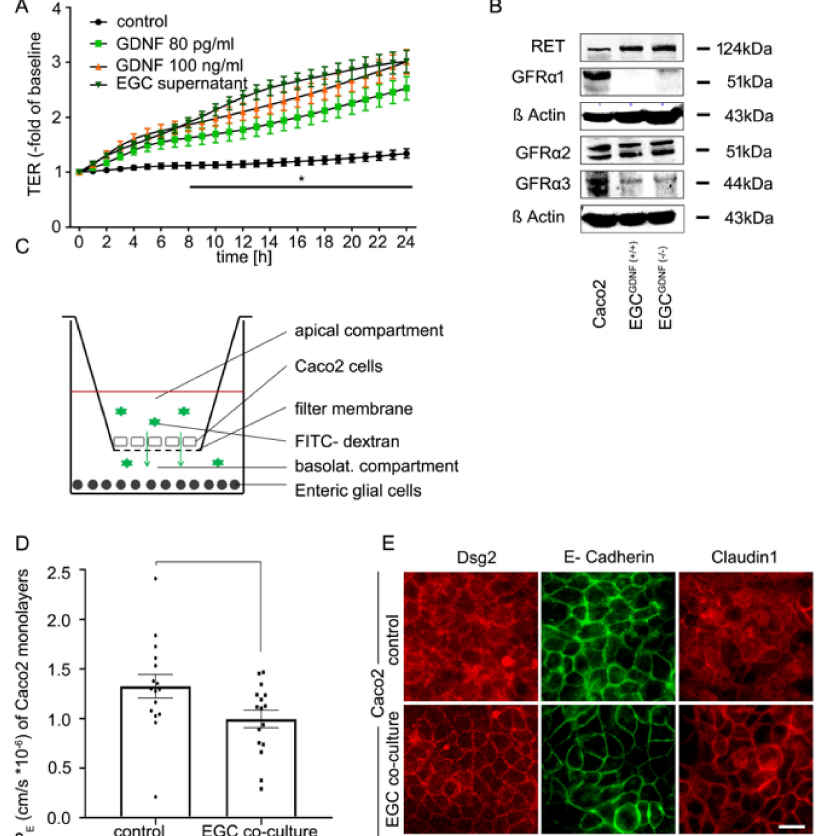
Figure 2. Co-culture of enteric glial cells (EGC) with Caco2 cells stabilizes epithelial barrier function. ( A ). Measurements of transepithelial electric resistance (TER) showed a significant increase beginning at 8 h after incubation with the supernatant of EGC and raised to 3.01 ± 0.1-fold of baseline (equates to 2.24-fold of controls) while incubation with glial cell line-derived neurotrophic factor (GDNF) at 100 ng/mL increased TER significantly to 2.99 ± 0.07 of baseline (2.23-fold of controls) after 24 h. Similar results were obtained when GDNF was applied at 80 pg/mL when TER increased to 2.52 ± 0.09 -fold of baseline (1.88-fold of controls); ( n = 6, * = significant different vs. control after 8 h for all other conditions; p < 0.05, two-way ANOVA). Control = Caco2 monolayer without treatment. ( B ). Western Blots of Caco2 cells and EGC cells (wilde type (WT) and GDNF-knockdown) confirmed that all these cell lines express GDNF receptors and RET ( n = 3). Quantification of the blots is shown in Supplementary Figure S1 ( C ). Schematic picture of the co-culture model of Caco2 cells and enteric glia cells. ( D ). Permeability coefficients (P E ) of 4-kDa FITC dextran flux across Caco2 monolayers were significantly reduced 24 h after co-culture with EGC ( p < 0.05, n = 16, student’s t-test). Control = Caco2 monolayer without treatment. ( E ). Immunostaining of the transwell filters showed an augmented and more linear staining pattern of desmosomal protein Desmoglein2 (Dsg2), adherens junction protein E-Cadherin and tight junction protein Claudin1 24 h after co-culture of confluent Caco2 cells with EGC compared to untreated controls (representatives are shown for n = 10, scale = 20 µ m). Control = Caco2 monolayer without